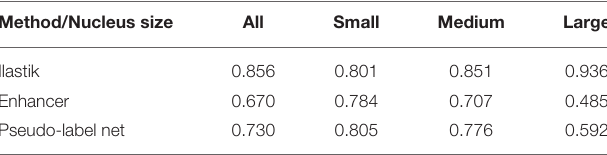
TABLE 9 | F1-scores for nucleus segmentation in fluorescence microscopy images. Method/Nucleus size